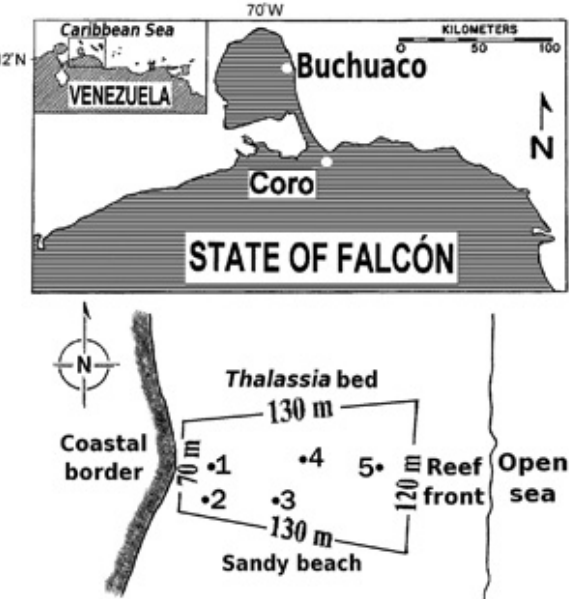
F IG . 1. – Relative location of Buchuaco (Venezuela), and location of the sampling sites. 1= Zone 1; 2= Zone 2; 3= Zone 3; 4= Zone 4; 5= Zone